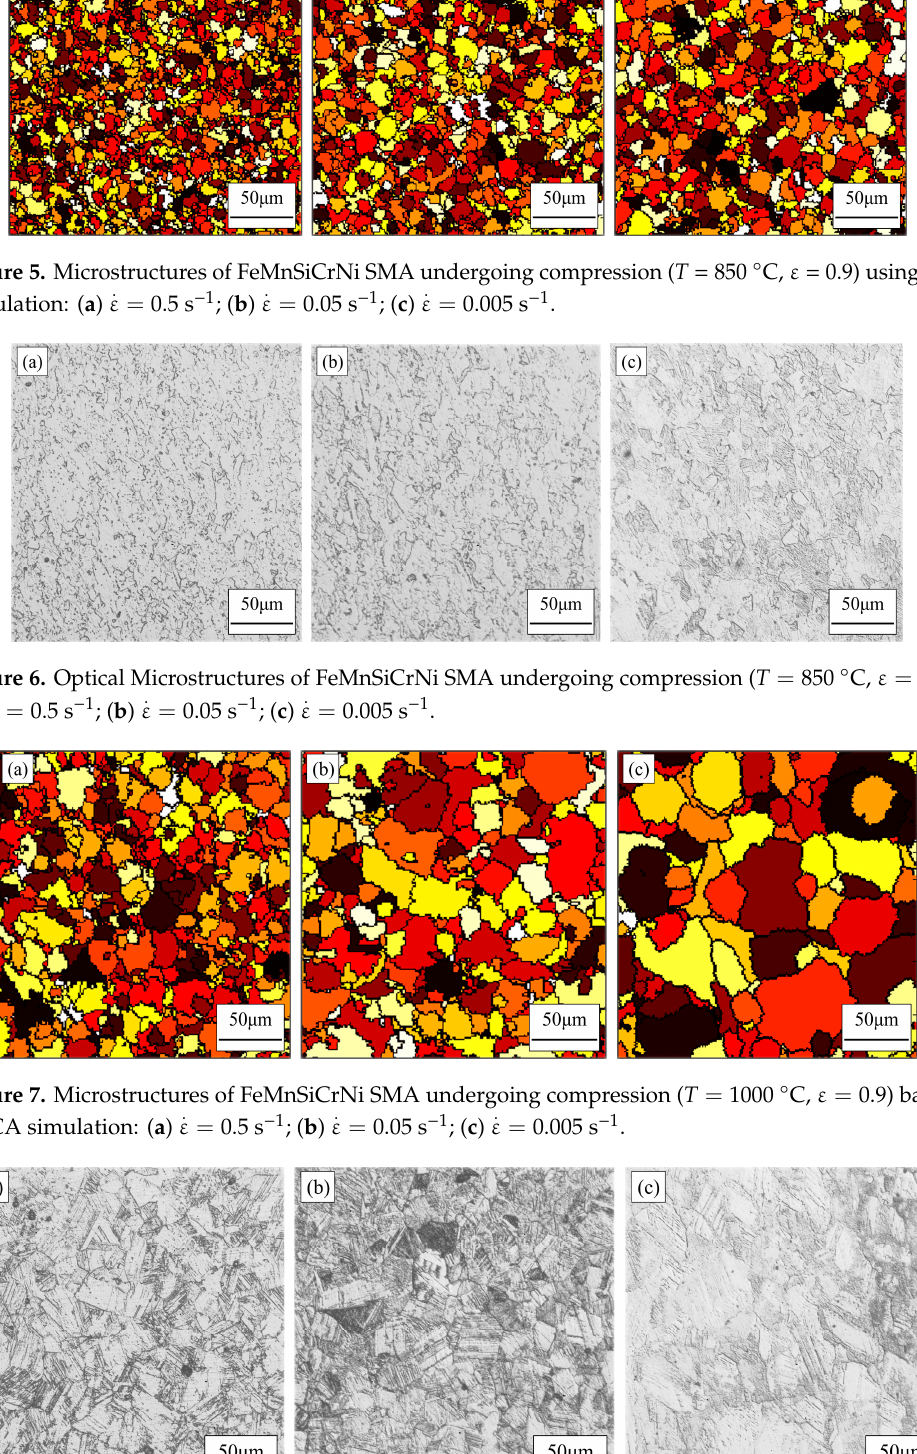
Figure 5. Microstructures of FeMnSiCrNi SMA undergoing compression (